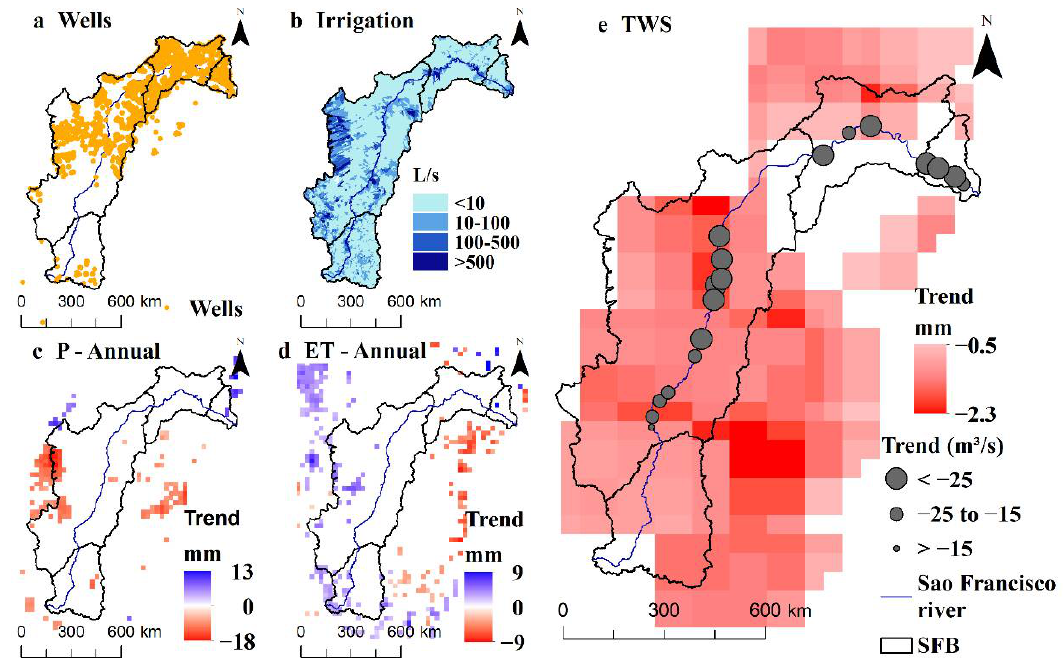
Figure 4. ( a ) Location of the wells. ( b ) Irrigation demand over the Sao Francisco River. Annual trend magnitude: ( c ) precipitation (P), ( d ) evapotranspiration (ET), and ( e ) terrestrial water storage change (TWS) and baseflow. Trends in baseflow along the Sao Francisco River are indicated by the grey circles. Trends were assessed using the Mann − Kendall and Theil–Sen’s slope estimator at 0.05 of the significance level. White color means a nonsignificant